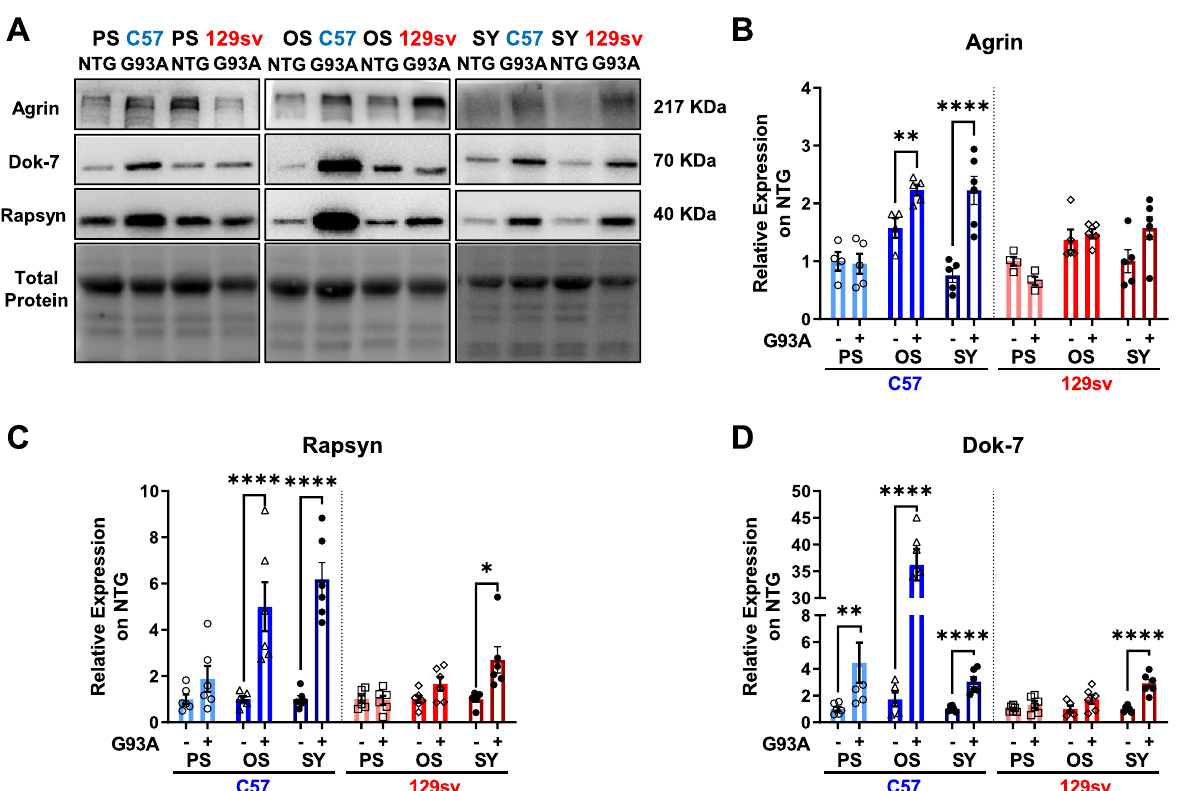
Fig. 3 Nicotinic acetylcholine receptor clustering in the skeletal muscles of fast- and slow-progressing mice. A – D Representative immunoblot images (full blots images in Additional file 2) and relative densitometric analysis of Agrin ( A and B ), Rapsyn ( A and C ), and Dok-7 ( A and D ) protein expression in GCM muscles of C57SOD1 G93A and 129SvSOD1 G93A mice compared with NTG littermates ( n 4–6). Protein levels were normalised on = the total amount of protein loaded. Data are reported as mean SEM. Significance was calculated with 2-way ANOVA with uncorrected Fisher’s LSD ± post-analysis (** p 0.01, **** p ≤ ≤